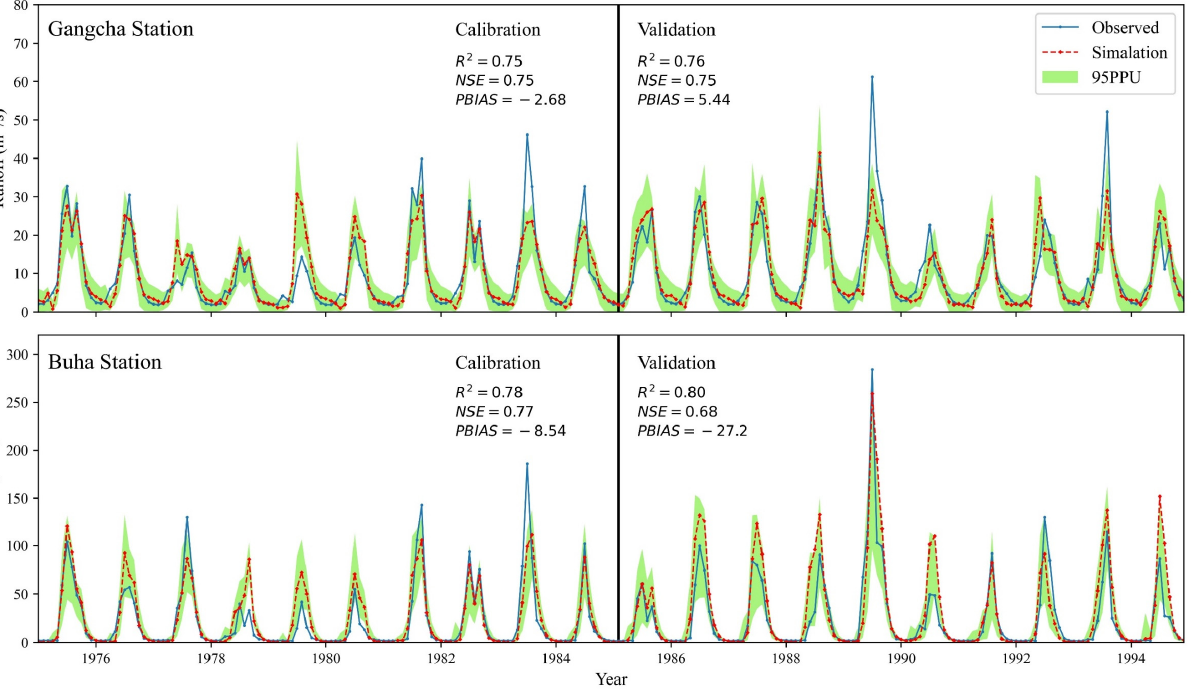
Figure 6. Observed and simulated monthly surface runoff for the calibration and validation period at Gangcha and Buha hydrologic stations with the performance statistics of R 2 , NSE and PBIAS. Green shaded area represents the prediction uncertainty (95PPU).